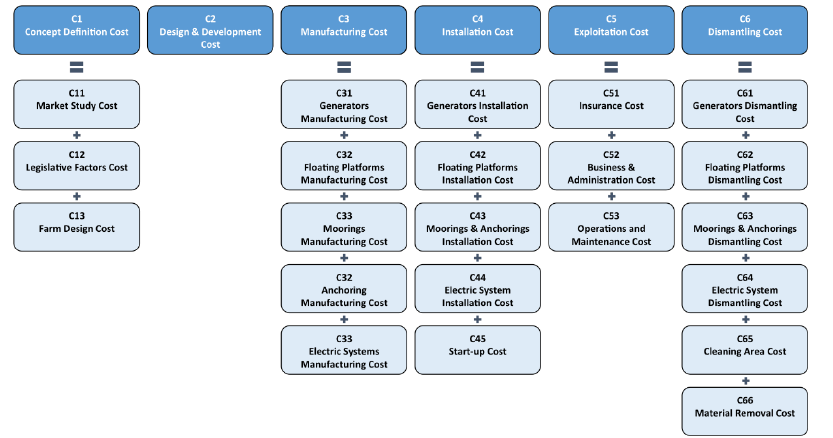
Figure 2. Sub-costs of the method proposed.